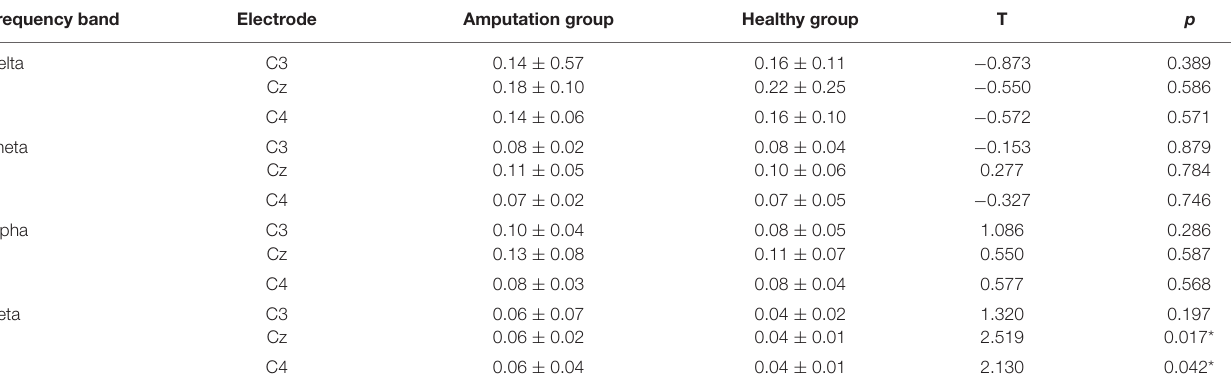
TABLE 2 | Difference in power values (mean ± SD) and the changes in power values of task-state EEG between healthy group and amputation group. Frequency band Electrode Amputation group Healthy